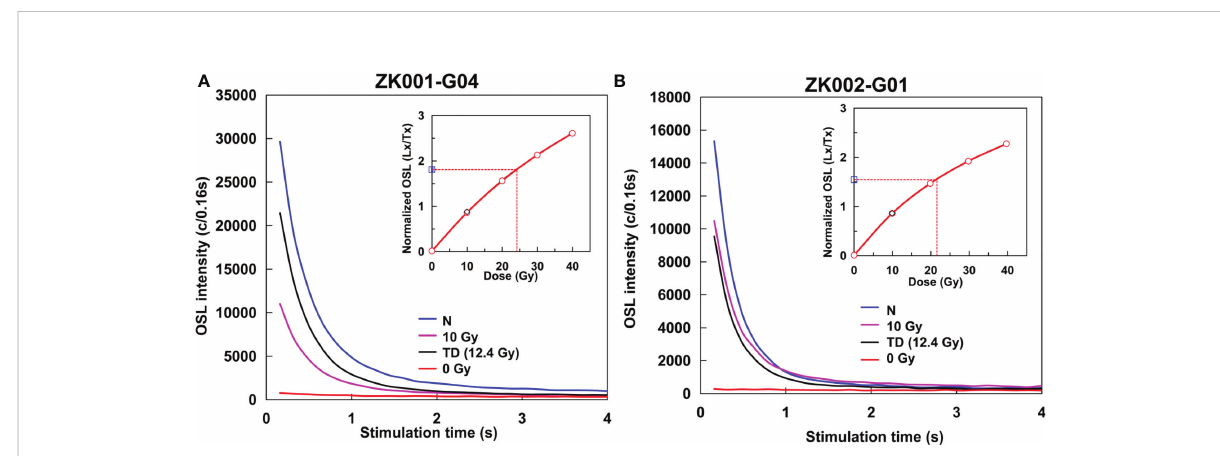
FIGURE 2 OSL decay and growth curves of samples ZK001-G04 (A) and ZK002-G01 (B) . The growth curves show the dose – response Lx/Tx (where Lx is the ratio of the luminescence signal and Tx is the fi xed dose). The decay curves of the natural dose (N), regeneration dose (R), and test dose (TD = 12.4 Gy) show the OSL signals decreasing rapidly during the fi rst second of stimulation, indicating that the OSL signal is dominated by the fast component in these